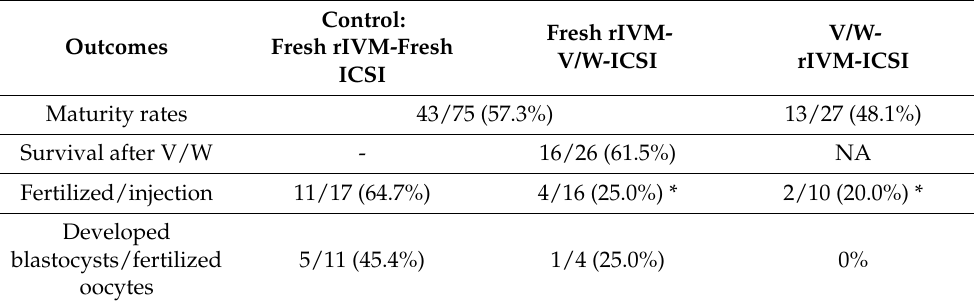
Table 1. Outcomes of rIVM, vitrification and warming (V/W), and fertilization and blastocyst development after ICSI.